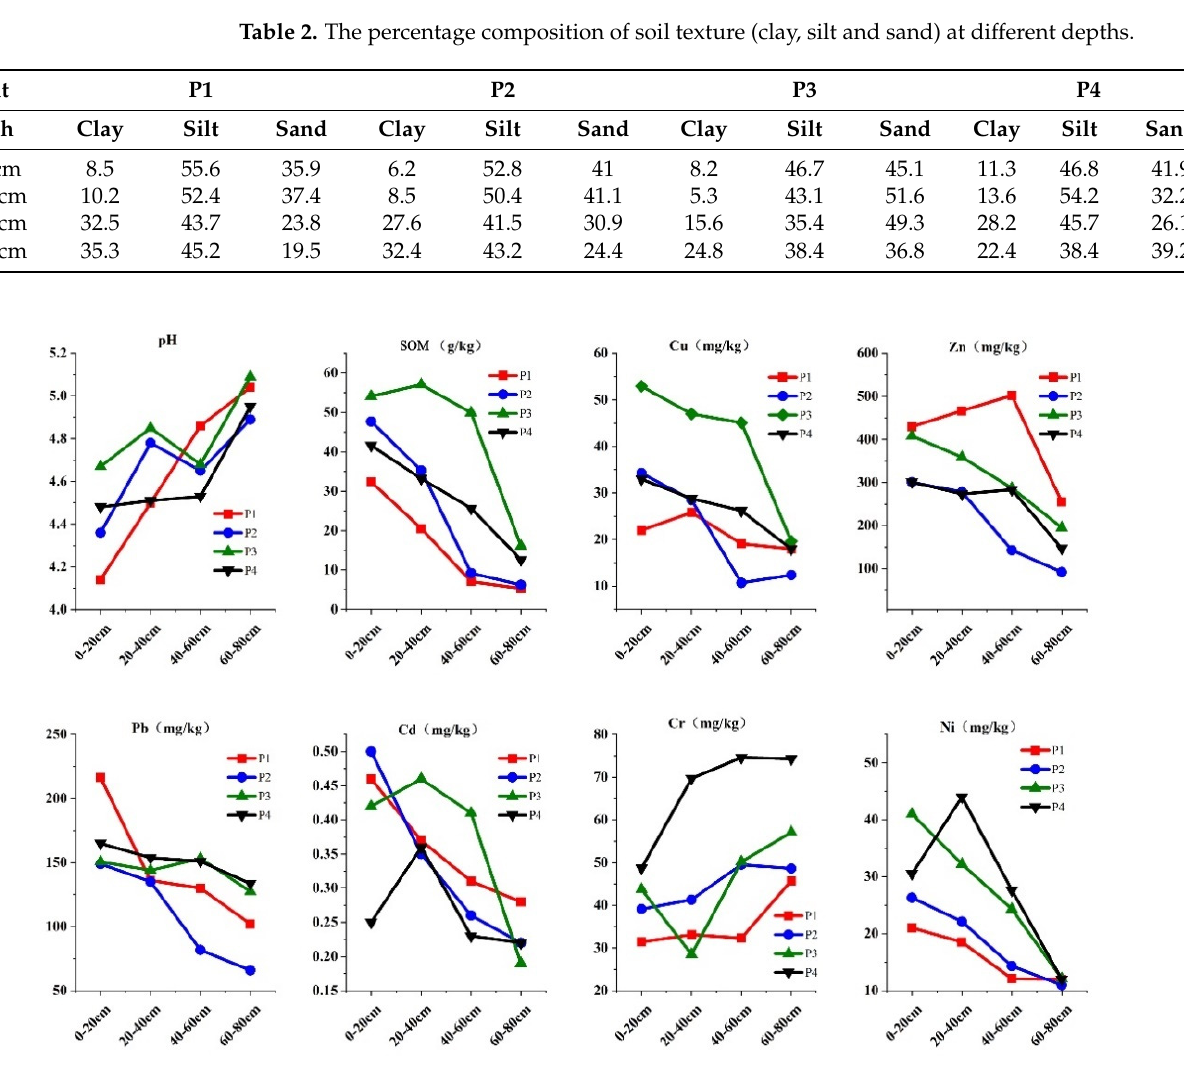
Figure 2. Distribution of heavy metals, pH and organic matter in soil profiles.